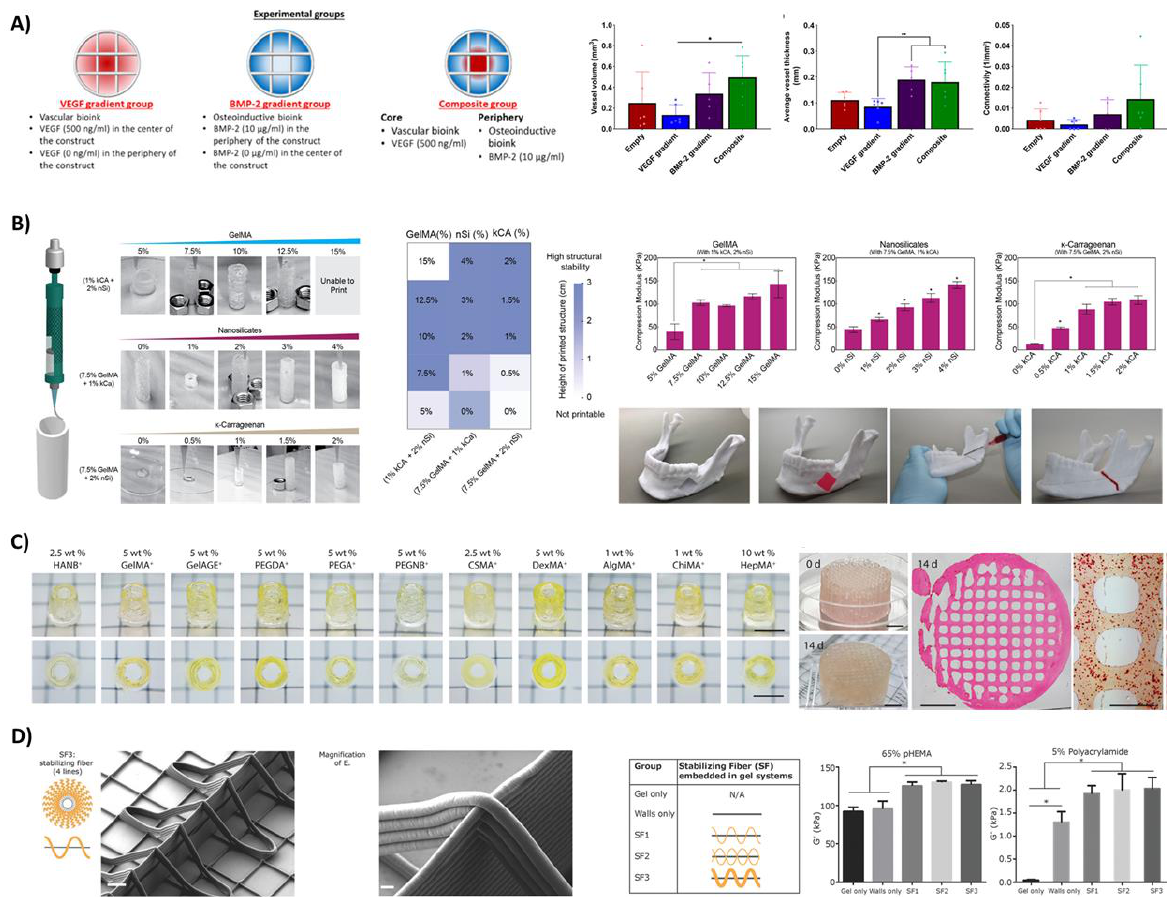
Figure 5. Examples of hybrid bioink strategies. Using dual extrusion technology to generate core – shell structures of nanoparticle functionalised alginate bioinks promotes vessel volume, vessel thickness as well as connectivity of encapsulated HUVECs, * p < 0.05 and ** p < 0.001 ( A ). Reprinted with permission from ref. [143]. Extrusion of hybrid bioinks made from combinations of GelMA, kappa-carrageenan, and nanosilicates enables a wide biofabrication window to generate clinically relevant and resilient constructs, * p < 0.05 ( B ). Reprinted with permission from ref. [147]. Three dimensional printed tubular constructs made of a variety of hyaluronic acid, gelatin, PEG, chondroitin sulphate, dextran, alginate, and heparin mixtures allows the maintenance of Saos-2 cells with osteogenic mineralisation ( C ). Reprinted with permission from ref. [98]. Other examples include adding stabilising polyacrylamide fibres in poly(2-hydroxyethyl methacrylate) mixtures, printing various orientations to tailor the mechanical properties, and increasing the complex shear modulus of implants, * p < 0.05 ( D ). Reprinted with permission from ref. [156].